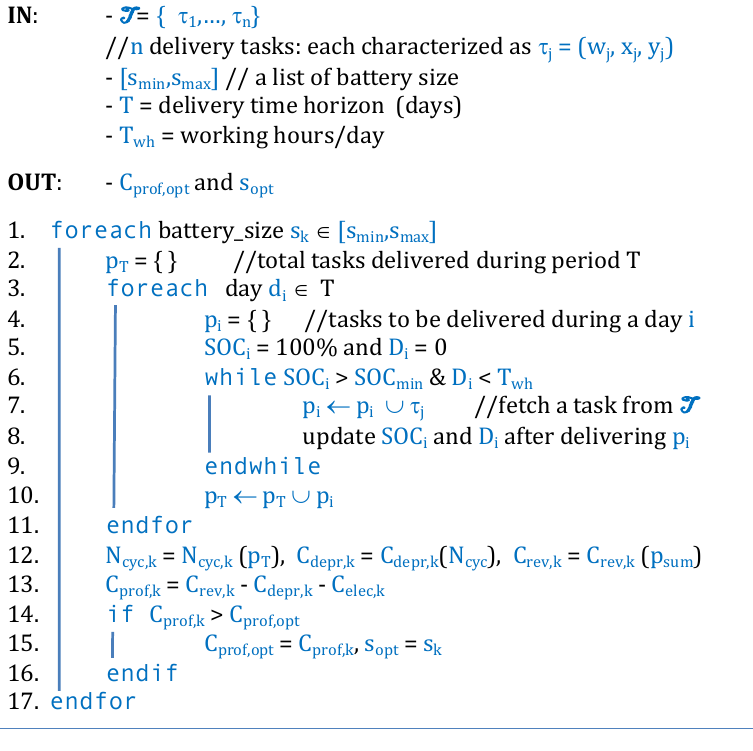
Figure 4. Delivery